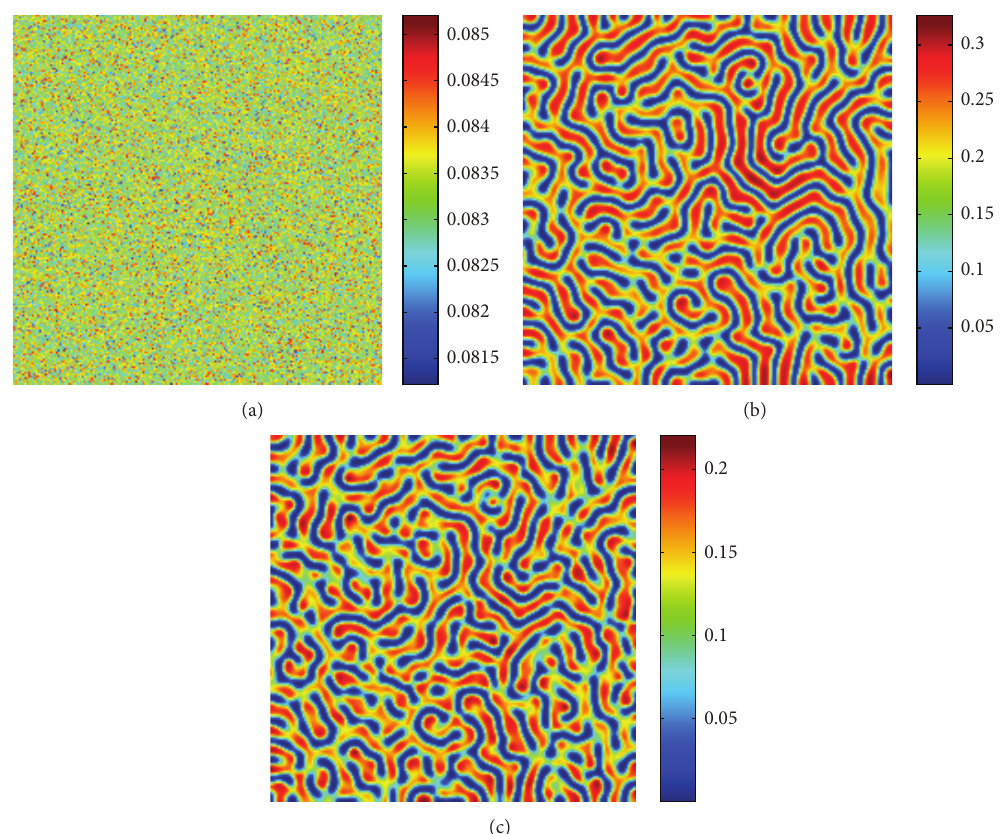
Figure 4: Snapshots of contour diagrams of the time evolution of algae at different points in time with 𝑁 = 0.25, 𝐷 2 = 0.5 . (a) 0 iterations, (b) 50000 iterations, and (c) 100000